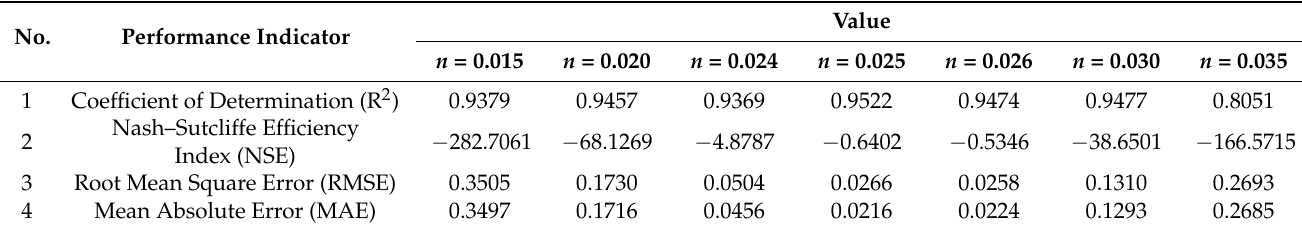
Table 2. Performance indicators of the calibrated Manning’s